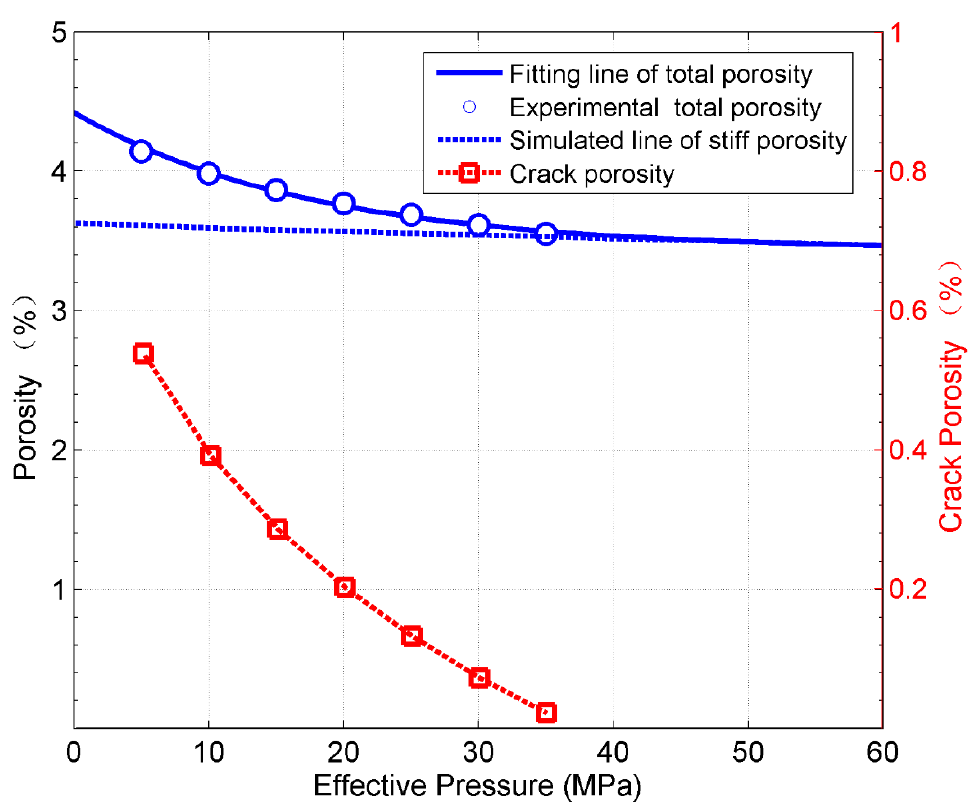
Figure 8. P- and S-wave velocities ( a ) and their ratio ( b ) as a function of effective pressure.